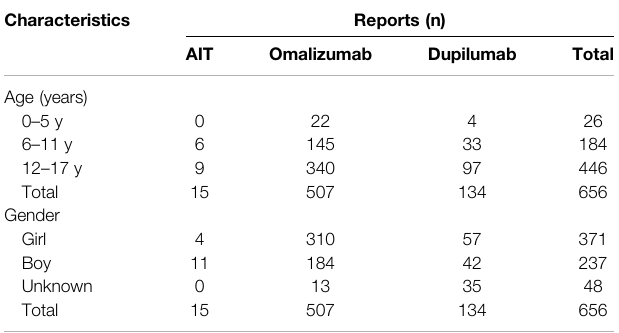
TABLE 5 | Indications for the application of AIT, omalizumab, and dupilumab in children. Indications